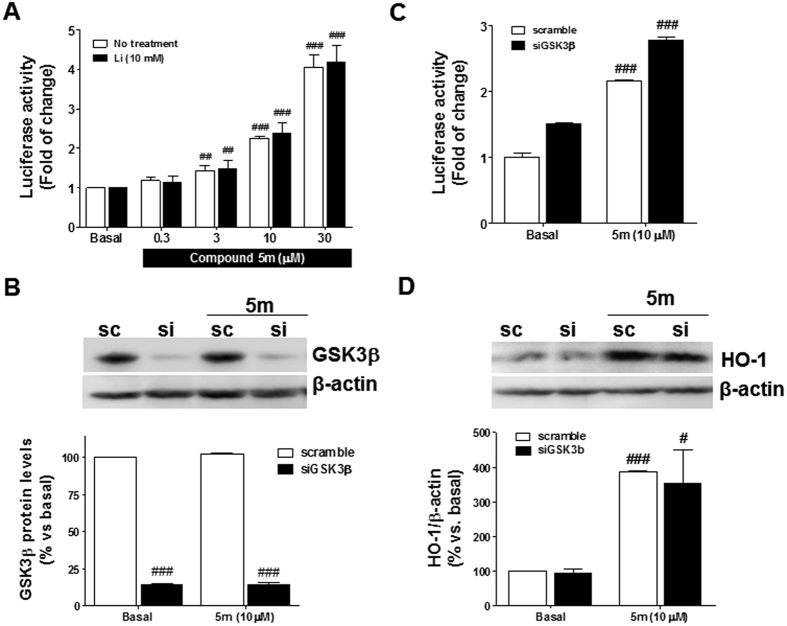
Nrf2 induction properties are independent of the GSK3β inhibitory activity.(A) Luciferase activity induced by compound 5m alone and in presence of lithium compared to basal conditions. (B) GSK3β silencing efficiency achieved by treating AREc32 cells with 25 nM of siRNA and 2 μL of DharmaFECT1 during 48 h. (C) Luciferase activity induced by compound 5m (10 μM) in AREc32 cells after 24 h. Cells were previously treated with scramble (white) or siGSK3β (black) silencing RNAs during 48 h. (D) HO-1 expression induced by compound 5m (10 μM) measured at the same experimental conditions used previously. Values are expressed as mean ± SEM of three independent experiments in duplicate. ###p < 0.001; ##p < 0.01; #p < 0.05 compared to the correspondent basal conditions.